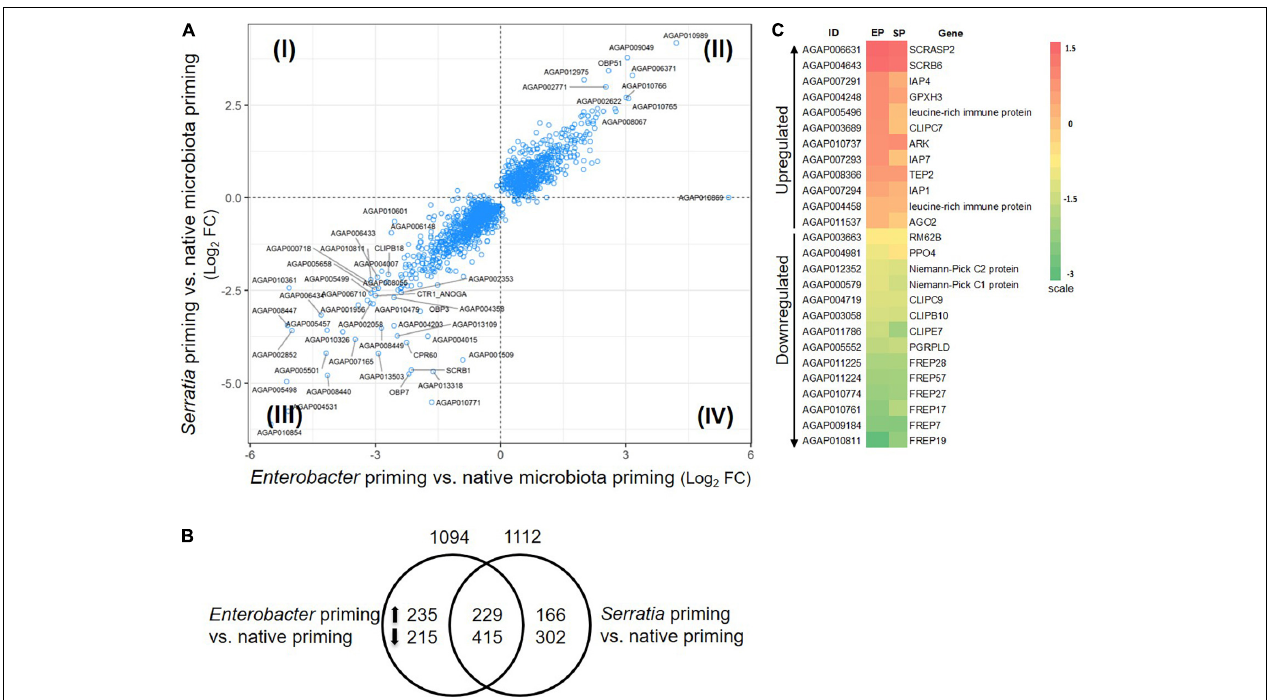
FIGURE 5 | Priming effect of single bacterial diet on the transcriptome without bacterial challenge. (A) Transcriptomes in the cohort with Enterobacter or Serratia priming showed a similar response pattern, majority of genes were regulated in the same direction, plotted in quadrant II and III. Plotted are genes with q -value less than 0.05 in either comparison to the cohort with native microbiota. Labeled genes have log 2 fold change (FC) in either comparison greater than 2.5 or less than –2.5. (B) Distribution of the genes that were altered by individual priming. Total number of altered genes is placed on top of the circle, the number of up- or down-regulated genes were specified inside the circle. (C) The heatmap illustrates the immune genes that were affected by the Enterobacter (EP) and Serratia (SP) priming compared to the native priming. The color scale represents the log 2 fold change between the EP or SP and native community.